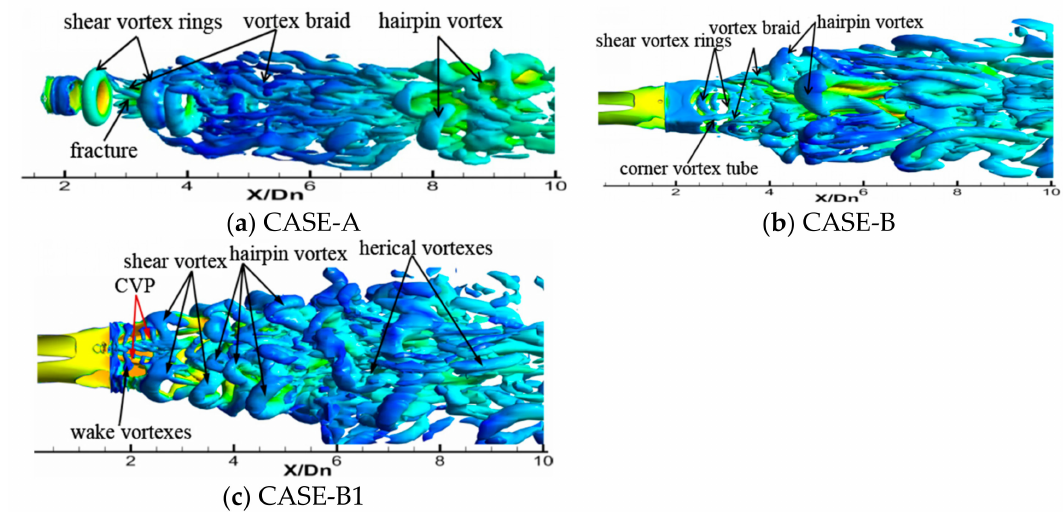
Figure 11. Distribution of dimensionless core areas along the axial direction at t = 0.02 s.